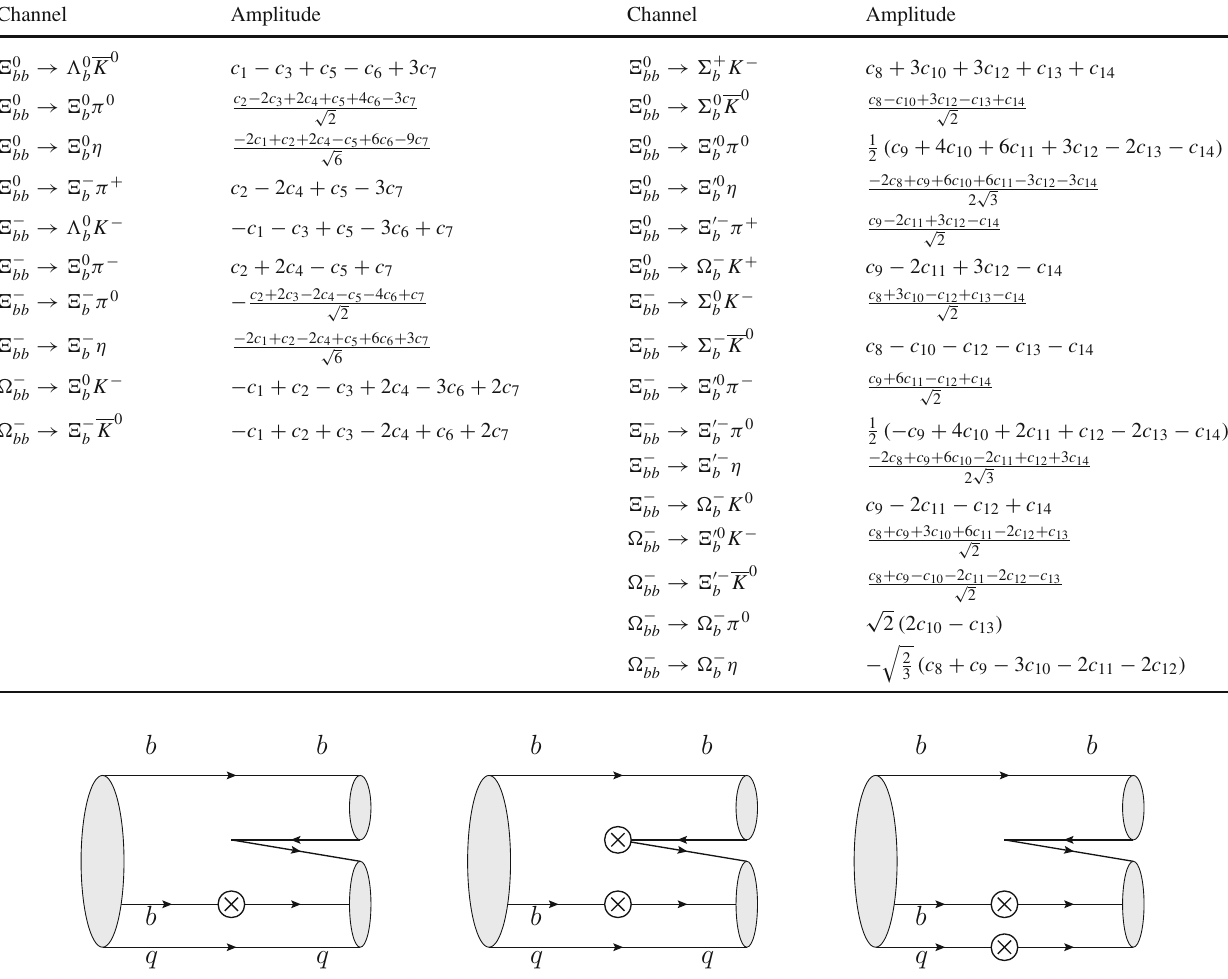
Table 18 Doubly bottom baryons decays into a bqq and a light meson induced by the charmless b → s transition Channel Amplitude Channel Amplitude (cid:2) 0 → (cid:3) 0 K 0 c 1 − c 3 + c 5 − c 6 + 3 c 7 bb b